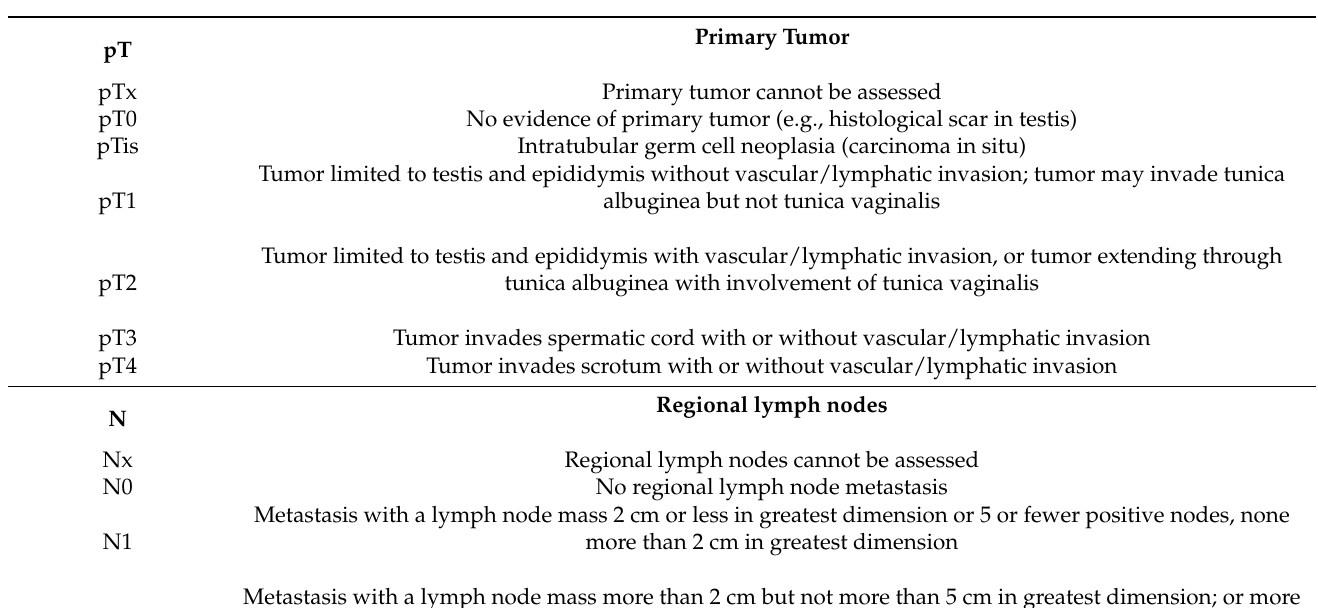
Table 1. TNMS staging for testicular cancer